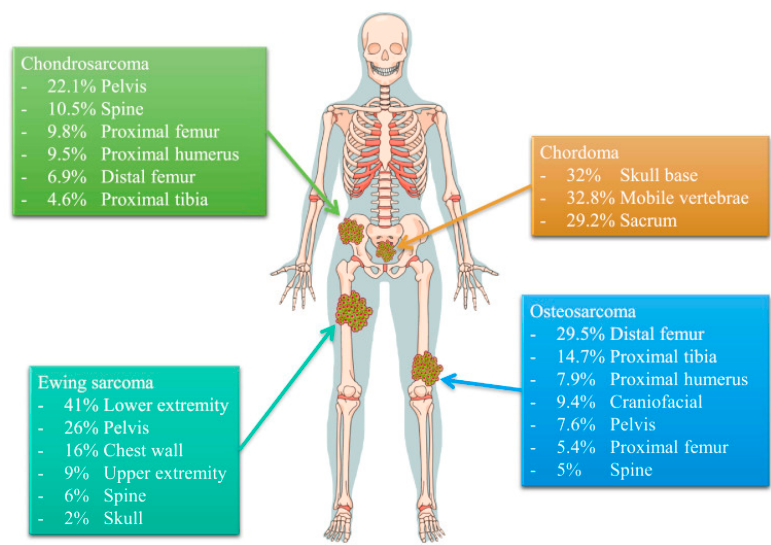
Figure 1. Anatomical distribution of common bone sarcoma. Reprinted from an open-access source [8].